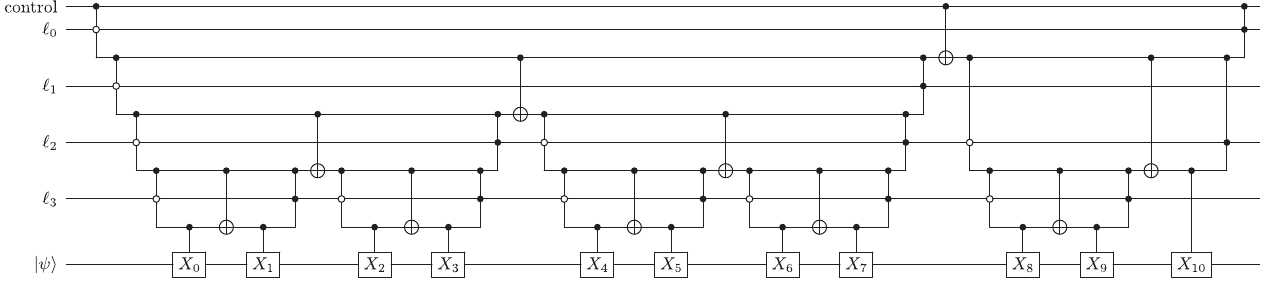
FIG. 7. An L ¼ 11 unary iteration circuit that applies X l to the qubit l in the system register j ψ i , where l is the value stored in the selection register. The circuit is obtained by merging AND operations from Fig. 5 using the method shown in Fig. 6. It computes 10 AND operations and so has a T count of 10 × 4 ¼ 40 ¼ 4 L − 4